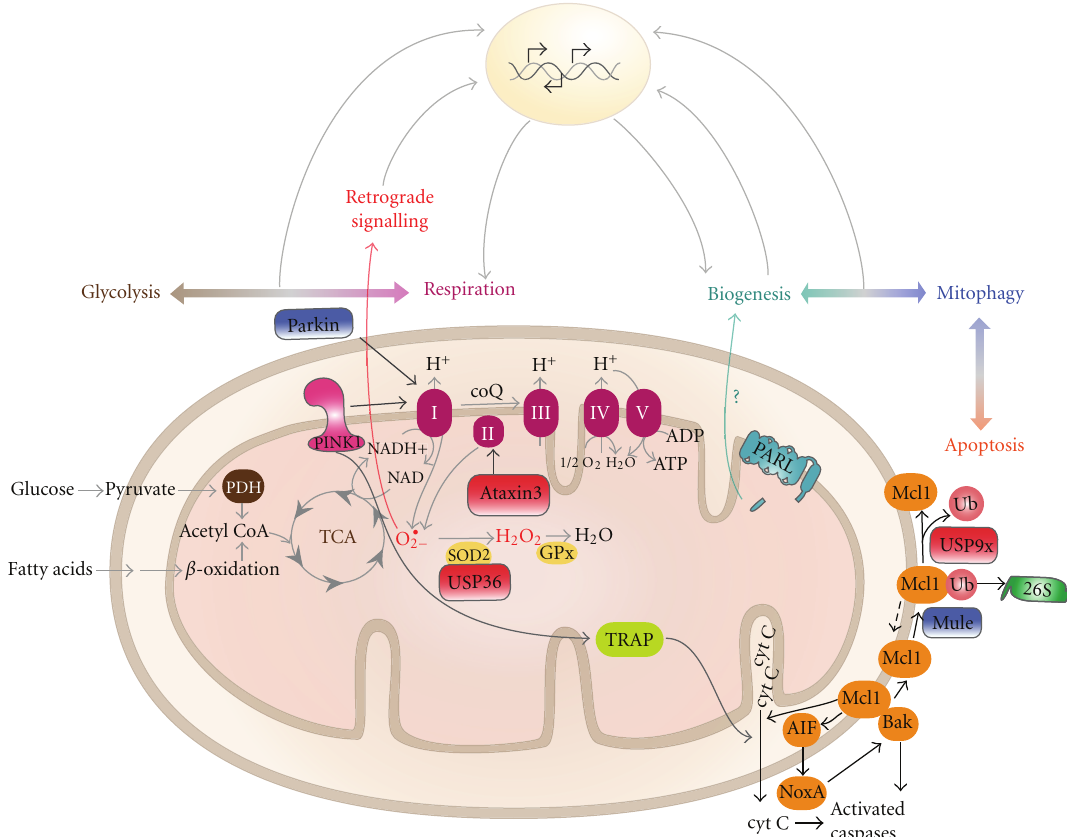
Figure 6: Interdependence of mitochondrial functions. Mitochondria generate ATP energy for the cell with the help of the electron transport chain. ATP fuels many cellular processes including protein degradation by the 26S proteasome. Hence, the process of oxidative phosphorylation (OXPHOS) influences the function of mitochondrial quality control systems. In the reverse direction, components of the quality control pathways can influence OXPHOS. Parkin mutants and defects in PINK1 have been shown to reduce mitochondrial respiration; PINK1 defects impair complex I functionality. In addition, mammalian studies with ataxin-3 mutants showed reduced complex II activity. Mitochondrial dysfunction can trigger apoptosis. Failures within the quality control system, coupled with an increase in ROS, can lead to the release of proapoptotic proteins. For example, if su ffi cient amounts of Mcl1 are not maintained due to unrestrained proteasomal degradation, Bak can facilitate the release of AIF/cytC and induce apoptosis. Hence, it is important for the quality control mechanisms to function properly in order to prevent unsolicited downstream e ff ects. Overall, the mitochondrial network has to maintain a refined balance between all of these processes and direct e ff ective metabolic outputs depending on the environmental and/or developmental